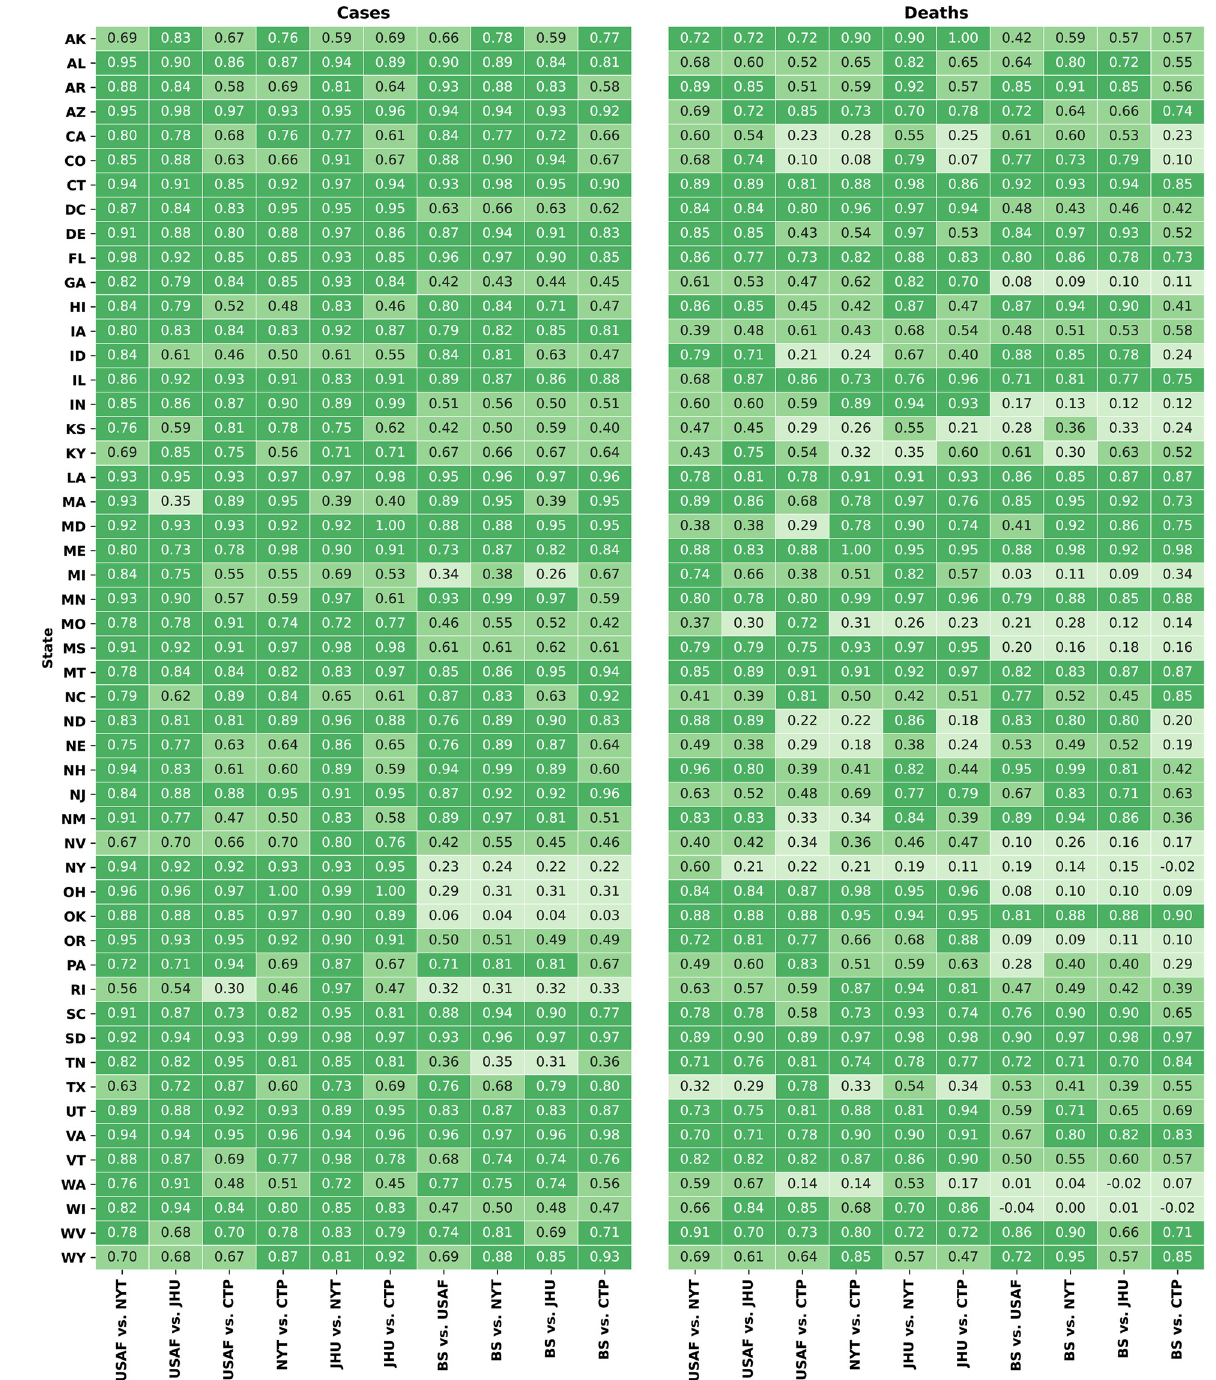
Fig 1. Provides the intra-rater reliability between each aggregator pair as Kappas state daily counts. Darker (1.00) to lighter (0.00) color indicates more to less agreement, respectively.